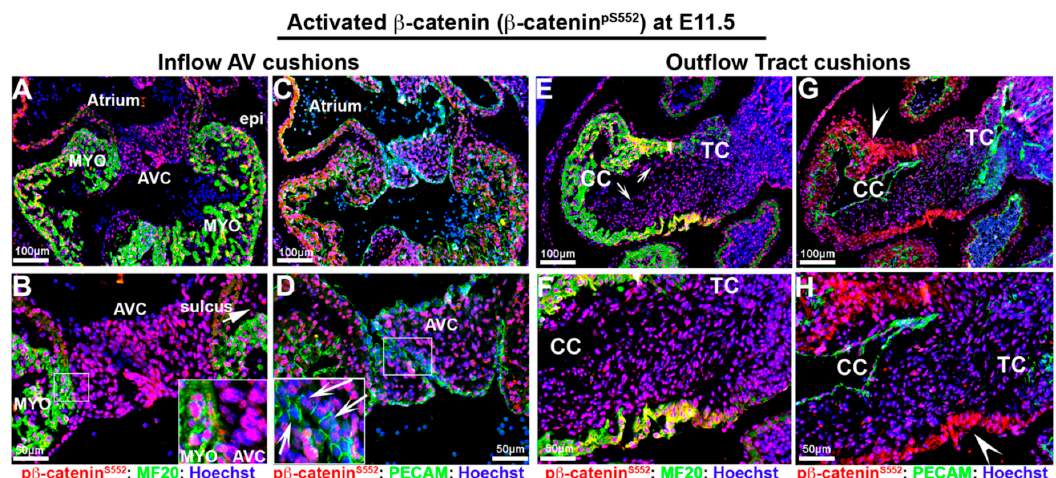
Figure 2. Activated β -catenin expression at E11.5 embryonic cardiac development. ( A – D ). Activated β -catenin (red) is ubiquitously expressed in the nuclei of virtually all cardiac cells including myocardium (myo), epicardium (epi), endothelium, sulcus tissue (arrow in ( B )) aortic and atrioventricular cushion (AVC) cells. Staining intensity is consistently lower at the area where the superior and inferior AV cushions fuse (( D )—arrows), and the boundary between AV cushions and myocardium reflections (( B )—boxed region). ( E – H ) In the outflow segment, activated β -catenin is observed throughout the myocardium and outflow tract cushions (( E )—arrows—and ( F )) Within the myocardial sleeve of the outflow tract, the cell membranes of myocytes were also stained positive for activated β -catenin (( G , H )—arrowheads). CC = conal cushions, TC = truncal